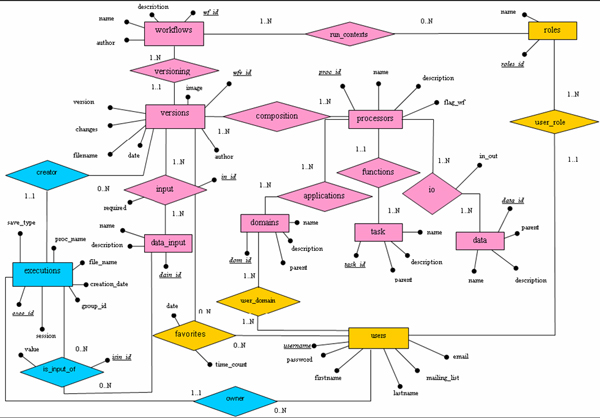
The biowep entity – relationships – attributes schema. In this schema, entities and relationships are coloured on the basis of their prevalent entity: yellow for data on users, magenta for information on workflows and cyan for the results of executions. It is important to note links between users' domains of interests and workflows' domains of application, as well as between users' roles and workflows' run contexts. Also, it should be noticed the difference between workflows and their versions and how the annotations and the executions data refer to versions.